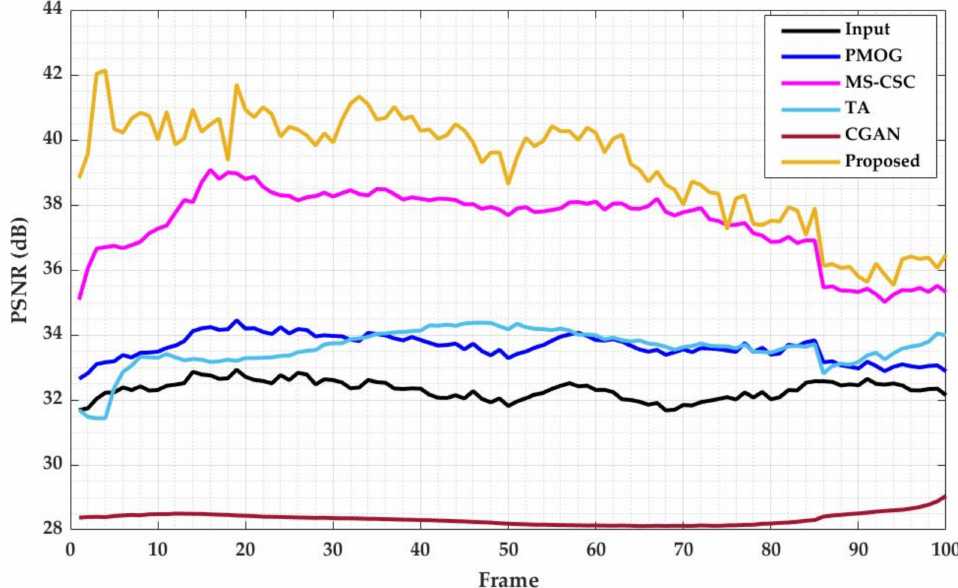
Figure 13. Quantitative comparison of the proposed method with relevant methods in terms of PSNR value.